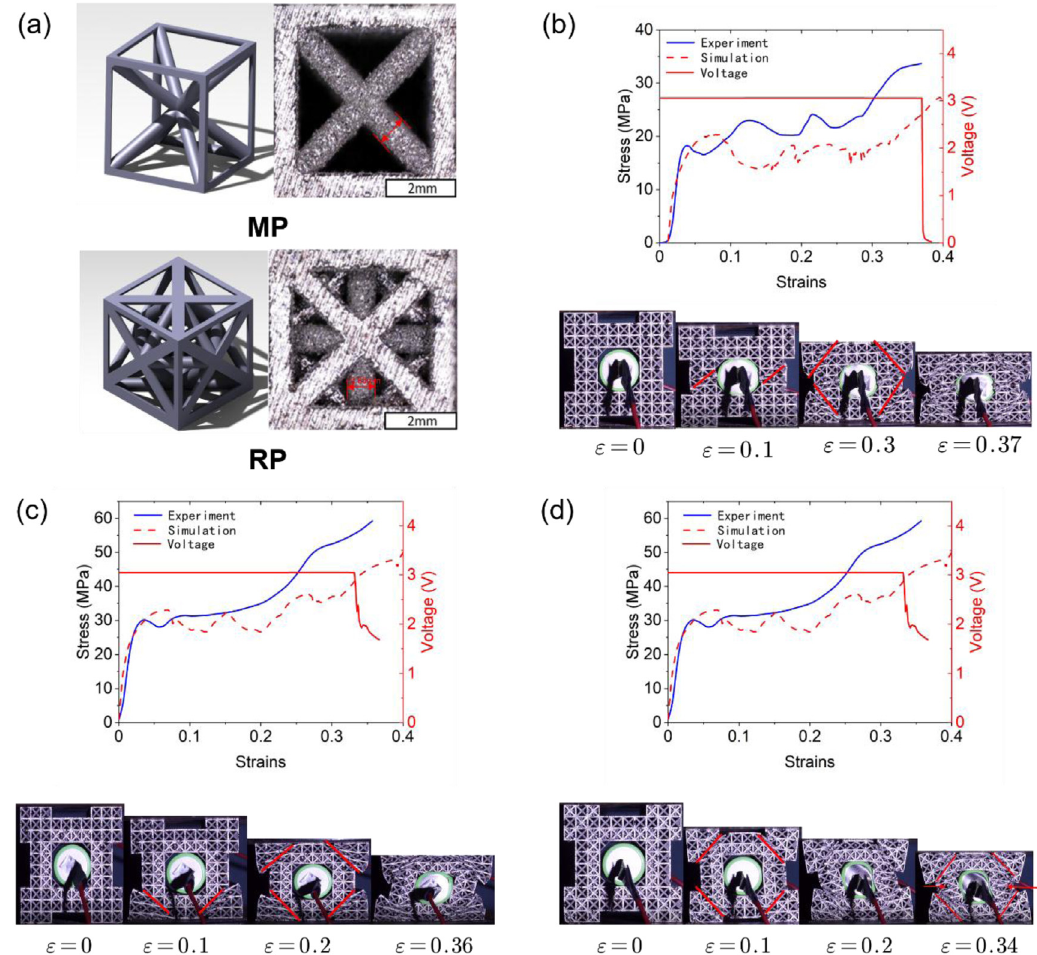
Fig. 2. Compression testing for the assembled structural battery system fabricated by SLM. (a) Mesoscopic truss morphology. (b, c, d) The voltage curve, engineering stress-strain curves, and deformation modes of the multfunctional system with different types of